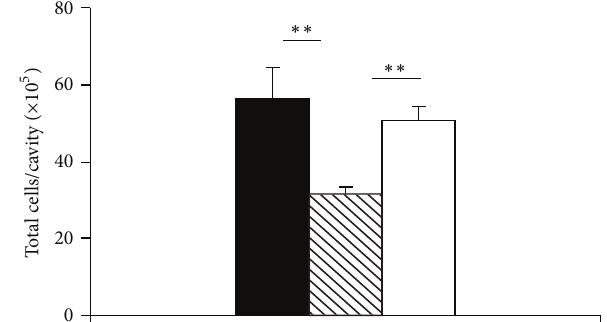
Figure 2: Accumulation of different leukocyte subtypes induced by eotaxin:effectofspecificantibodyneutralization . Eotaxinwasprein- cubated with specific neutralizing monoclonal antibody (hatched bar), or with irrelevant isotype-matched monoclonal antibody (openbar),beforei.p.injectioninBALB/cmice.Controls(blackbar) received eotaxin but no antibody. Peritoneal lavage fluid, collected 4 h later, was used for total leukocyte quantitation. Data are mean ± SEM. ∗∗ , 𝑃 ≤ 0,01 , for the differences relative to the positive (eotaxin) and specificity (irrelevant antibody) controls. Data from 5–18